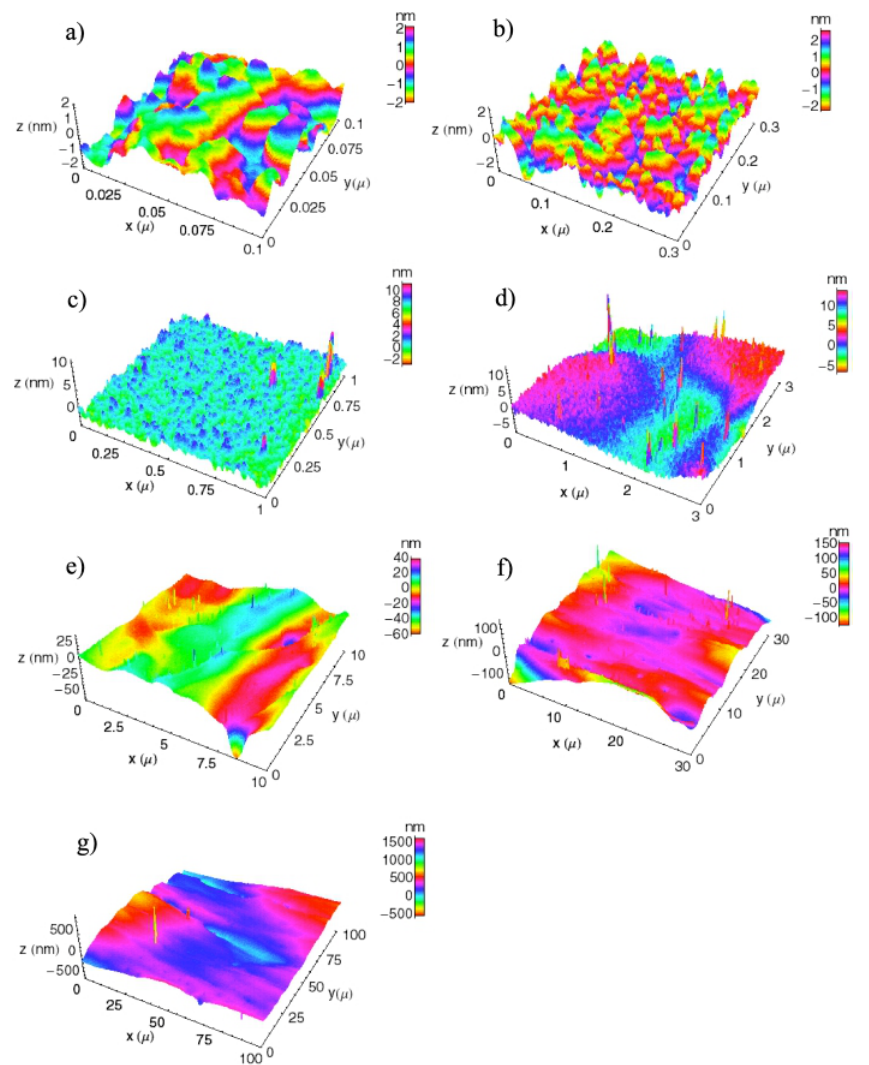
FIG. 1. (Color) AFM images ranging from 100 nm 3 100 nm to 100 m m 3 100 m m. The color scale next to each image indicates the height of the